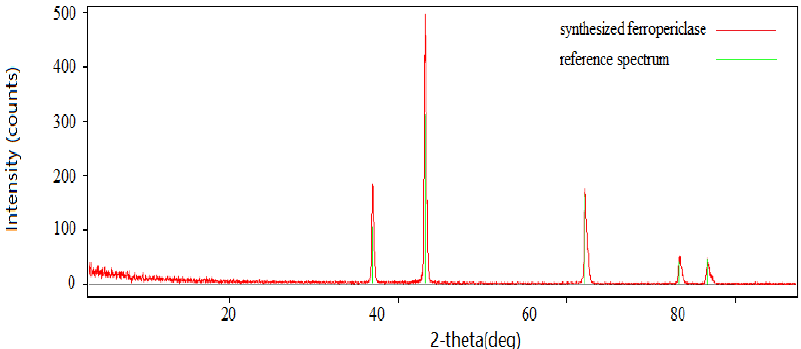
Figure 4. XRD pattern of the synthesized ferropericlase (red pattern) vs. reference spectrum (green lines).